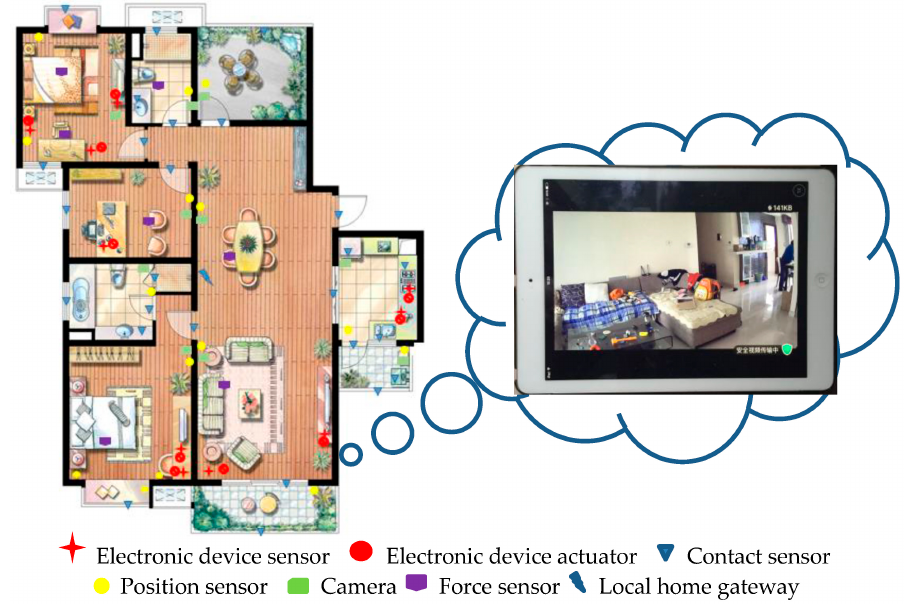
Figure 23. Layout of sensor deployment in the SH.